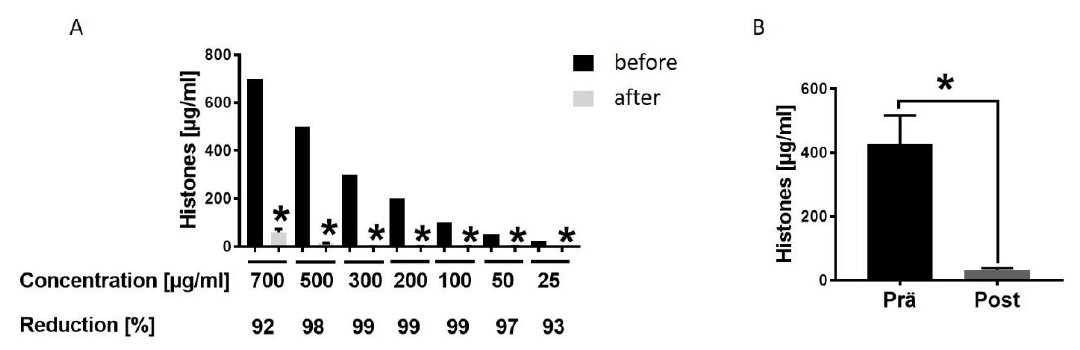
Figure 4. Hemadsorption—a therapeutic option to eliminate systemic extracellular histones. ( A ). Figure 4. hemadsorption — a therapeutic option to eliminate systemic extracellular histones. ( A ). Hemadsoption Hemadsoption of di ff erent concentrations of histones (700, 500, 300, 200, 100, 50, 25 µ g / mL) presented of different concentrations of histones (700, 500, 300, 200, 100, 50, 25 µg/mL) presented as percentage of reduction as percentage of reduction (%) after 6 hrs incubation time; for all concentrations n = 6. ( B ). Histone (%) after 6 hrs incubation time; for all concentrations n = 6. ( B ). Histone levels in blood plasma of 22 multiple levels in blood plasma of 22 multiple injured humans ( µ g / mL) in the Emergency room (pre) and after injured humans (µg/mL) in the Emergency room (pre) and after hemadsorption for 6 h (post). Results were hemadsorption for 6 h (post). Results were presented as SEM, * p < presented as SEM, * p < 0.05.